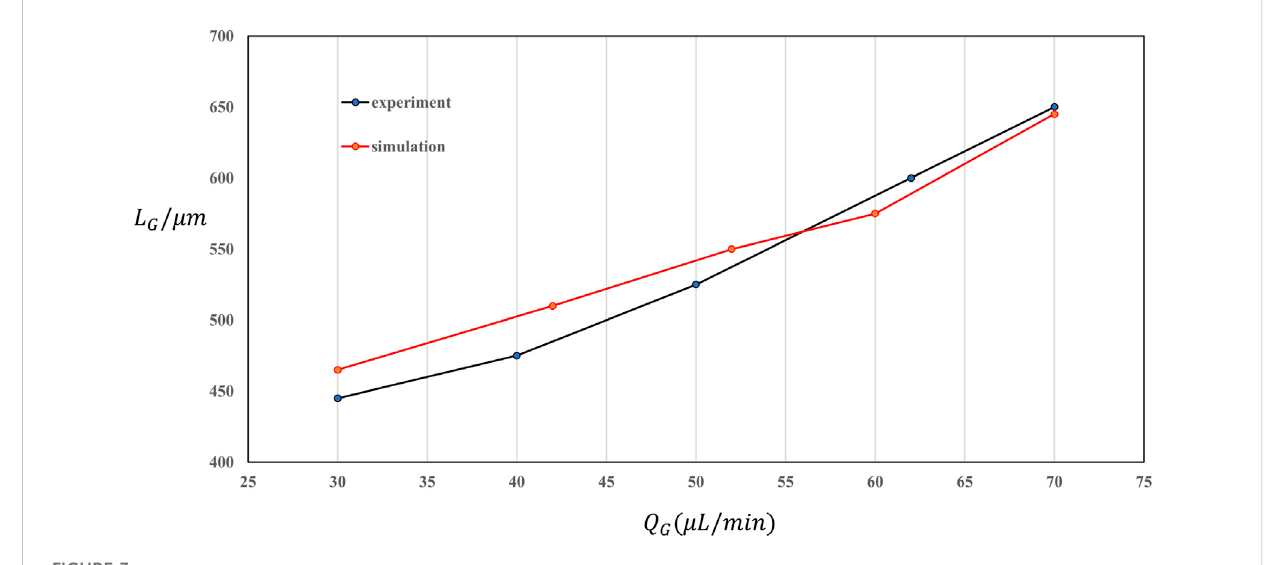
FIGURE 3 Comparison results of experiment and simulation.